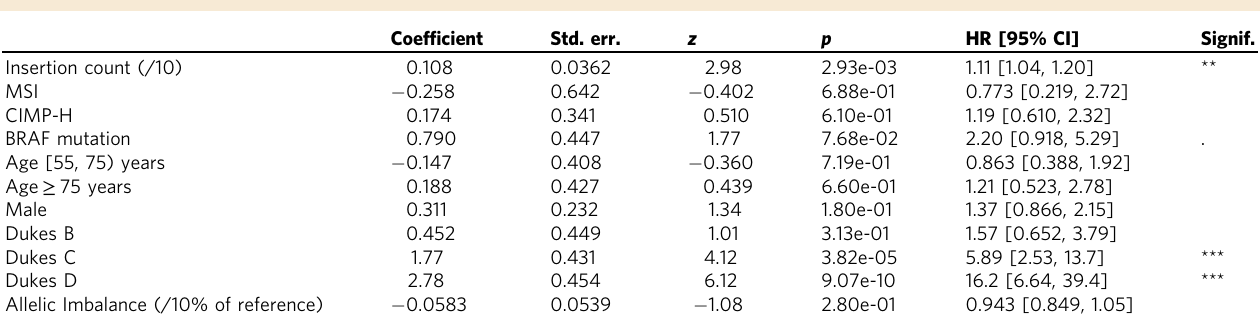
Table 3 Cox proportional hazards model for disease-speci fi c survival Coef fi cient Std. err. z p HR [95% CI]